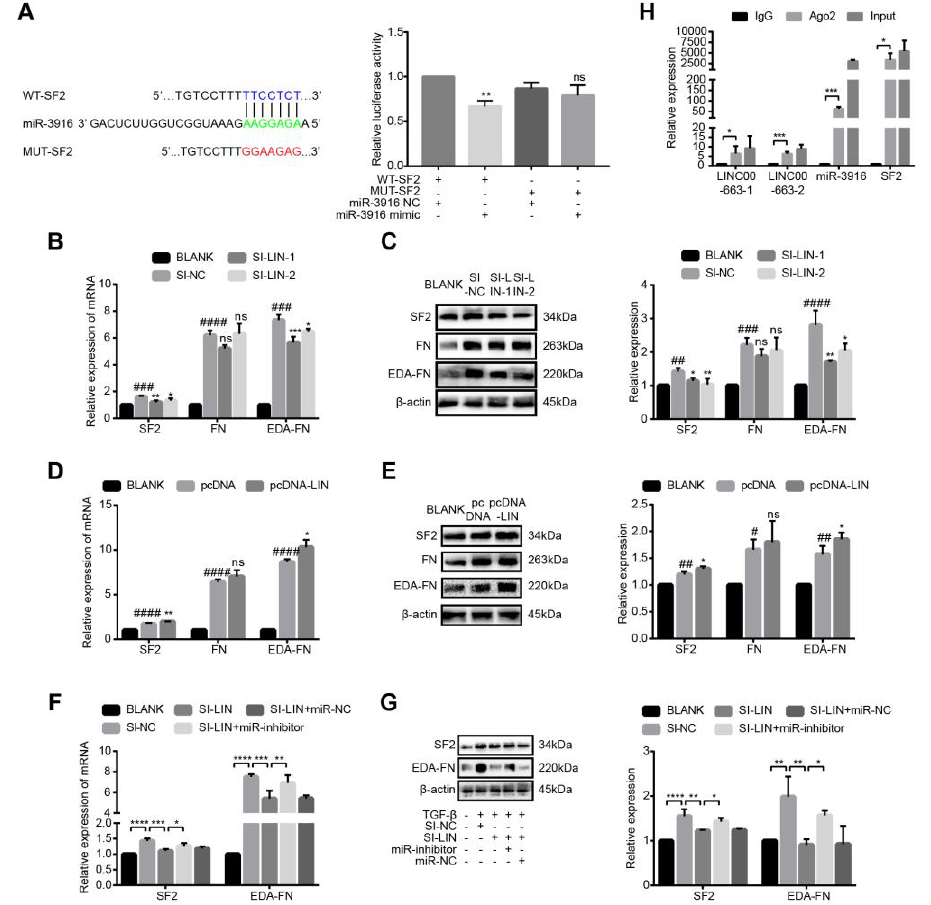
Figure 7. LINC00663 regulated SF2-FN alternative splicing by sponging hsa-miR-3916. ( A ) A schematic diagram showing the sequences of wild-type and mutant SF2 with hsa-miR-3916. A dual-luciferase reporter gene assay was performed to identify the interaction between SF2 and hsa-miR-3916. Relative expression of SF2, FN, and EDA-FN in LX-2 cells transfected with si-LINC00663 detected by ( B ) RT-qPCR and ( C ) WB. Relative expression of SF2, FN, and EDA-FN in LX-2 cells transfected with pcDNA-LINC00663 detected by ( D ) RT-qPCR and ( E ) WB. Relative expression of SF2 and EDA-FN in si-LIN, miR-inhibitor, or both transfected LX-2 cells detected by ( F ) RT-qPCR and ( G ) WB. ( H ) RIP experiment with anti-Ago2, IgG as a negative control, and input as a positive control from LX-2 cell extracts using RT-qPCR. * p < 0.05, ** p < 0.01, *** p < 0.001, **** p < 0.0001. ## p < 0.01, ### p < 0.001, #### p < 0.0001. * vs. NC, # vs. BLANK. ns vs. BLANK, not statis- tically significant. Each experiment was repeated three times and similar results were obtained. EDA-FN, extra domain A of fibronectin, FN, fibronectin; RIP, RNA immunoprecipitation; RT-qPCR, real-time quantitative PCR; SF2, splicing factor 2; siRNA, small interfering RNA; WB, western blot. 3.11. LINC00663 Regulated by the Transcription Factor FOXA1 We used PROMO and JASPAR to predict the binding site of FOXA1 to the LINC00663 promoter region (Figure 8A). Wild and mutated promotor sequences were constructed in a pGL3-basic vector. A dual-luciferase activity test showed that co-transfection of wild-LINC00663 and pGL3-FOXA1 increased luciferase activity (Fig- ure 8B, p < 0.05) illustrating that FOXA1 bound to the promoter region of LINC00663. Furthermore, FOXA1 expression was upregulated in activated LX-2 cells compared to a control group (Figure 8C,D, p < 0.05). To investigate the relationship between FOXA1 and LINC00663, activated LX-2 cells were transfected with si-FOXA1 or pEGFP-FOXA1. We found that FOXA1 upregulated LINC00663 (Figure 8E,F, p < 0.05). Moreover, we